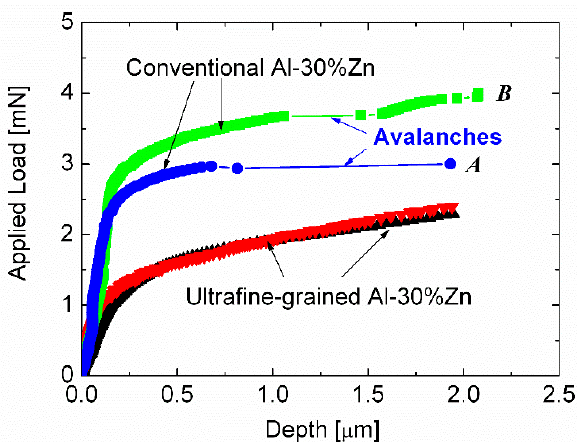
Figure 15. Typical load-depth curves obtained by compressing single-crystal (denoted as conventional) and ultrafine-grained Al-30 wt %Zn micro-pillars, showing typical strain avalanches in the single crystal micropillars, and the avalanche-free, stable deformation of the UFG micropillars. The single crystal pillars A and B have orientations near <100> and <111>, respectively. Reproduced with permission from [68]. Copyright 2014, Wiley (Hoboken, NJ, USA).